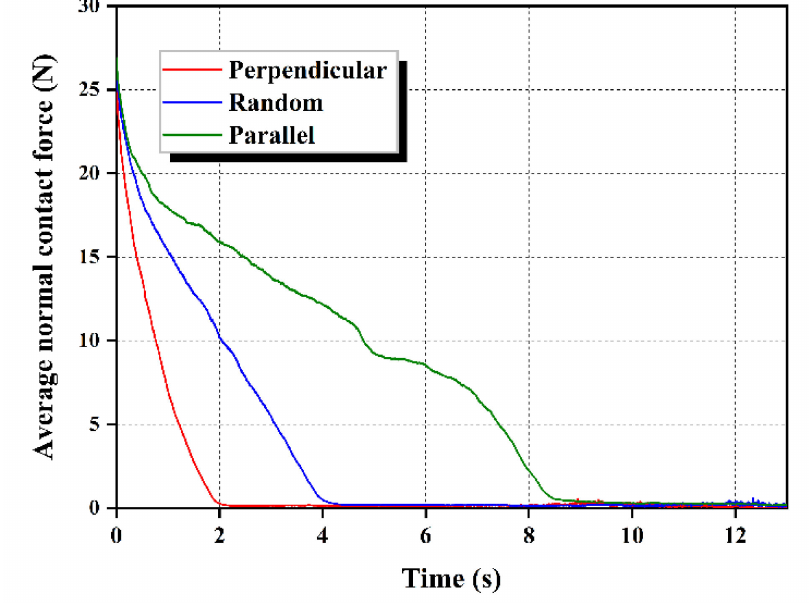
Figure 16. Evolution of the mean normal force acting on the fiber-sand